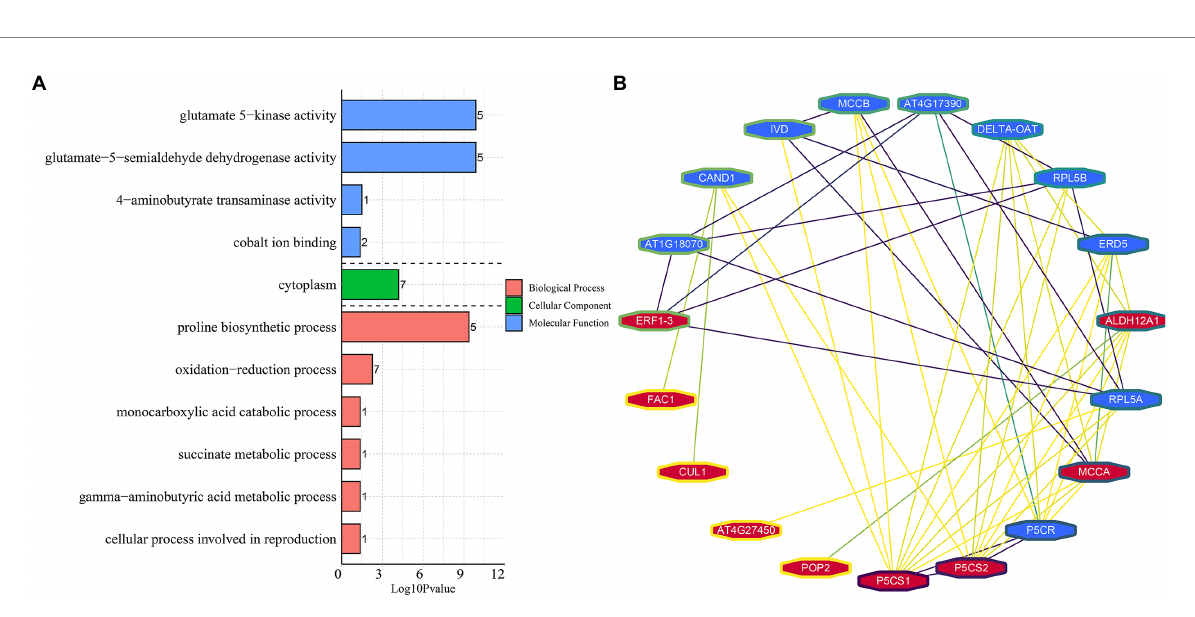
FIGURE 8 Functional enrichment (A) and protein–protein interaction analysis of 29 hub DEGs (B)